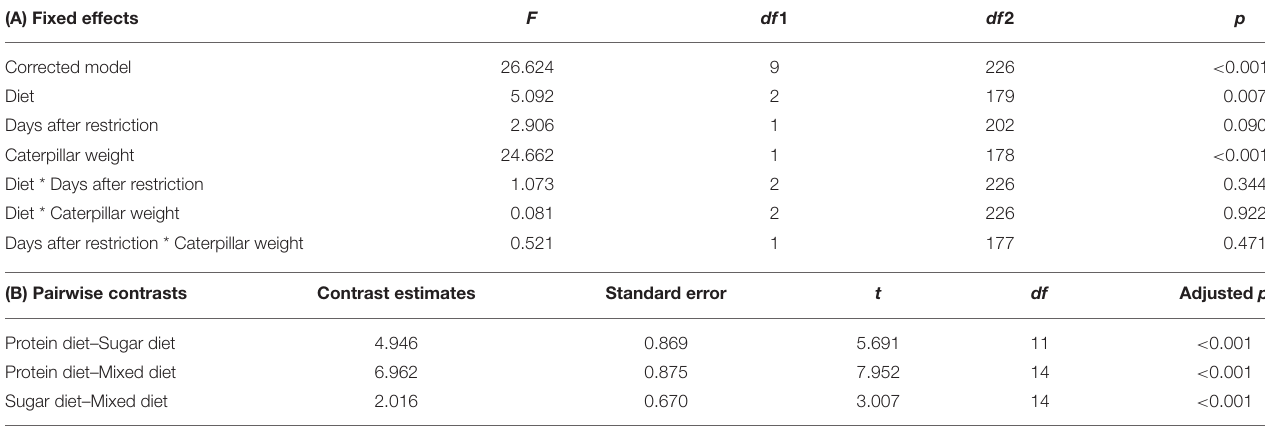
TABLE 3 | Test statistics for the generalized linear mixed model with the number of ants attending the caterpillar as the target